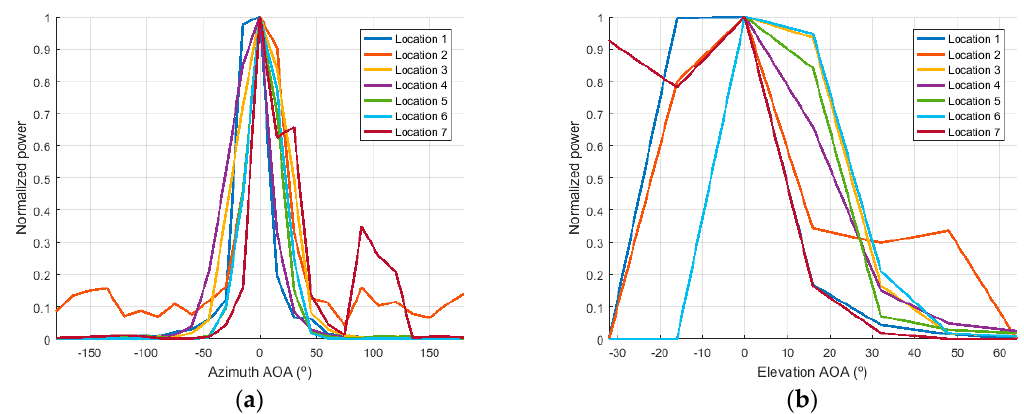
Figure 7. APDs for wooded environment ( a ) azimuth and ( b ) elevation.